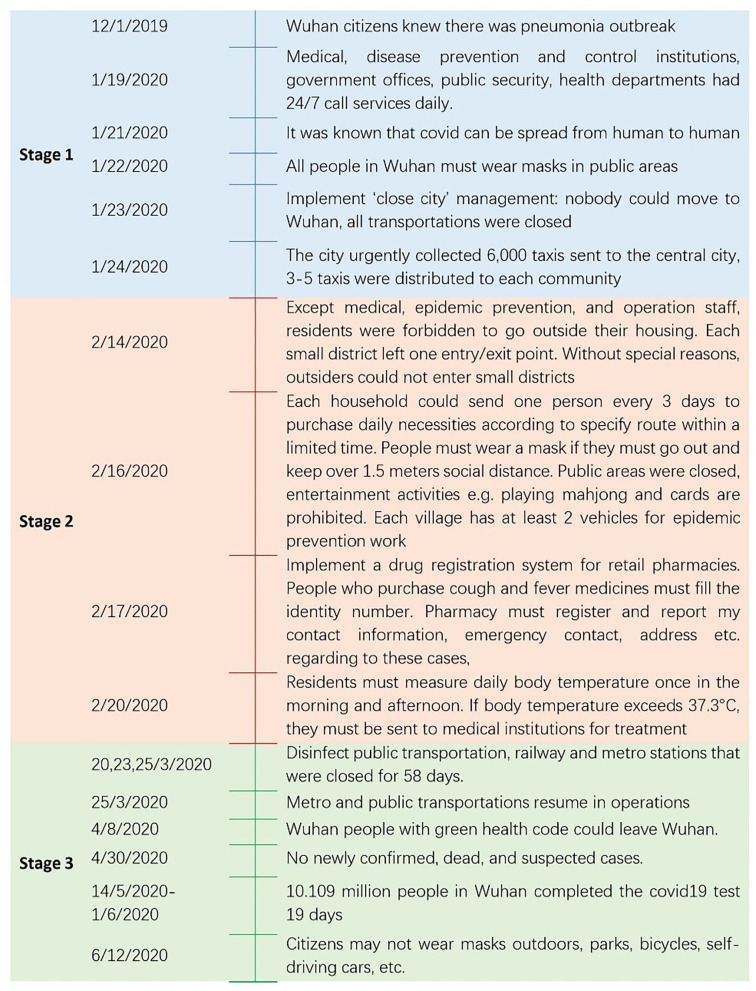
Three stages of covid-19 measurement (15, 20, 22, 23).